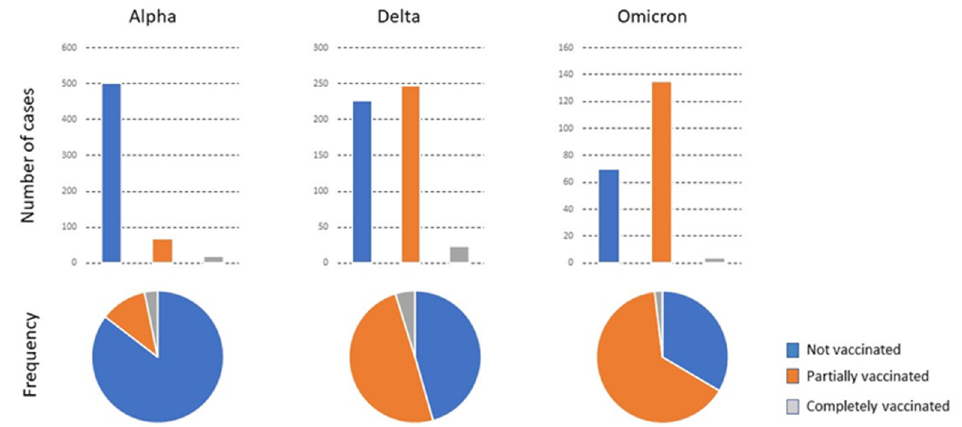
Figure 1. The total number of patients admitted with the predominant variant, their vaccination status, and the frequency of each status relative to the total number of infected individuals.